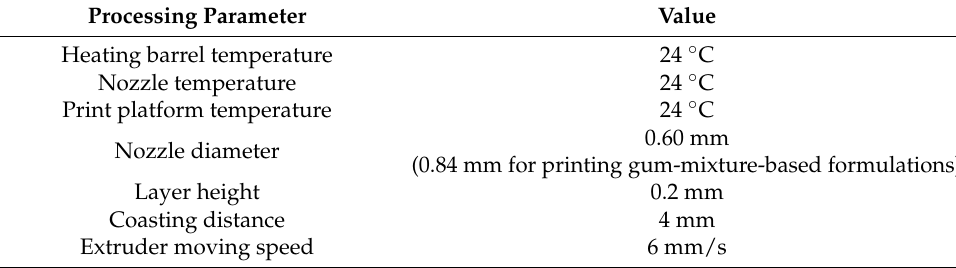
Table 2. Three-dimensional (3D) printing parameters used in this